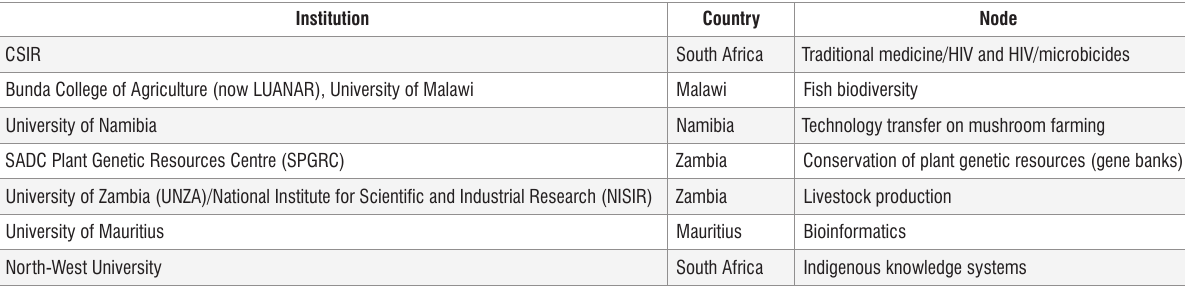
SANBio Members Institution